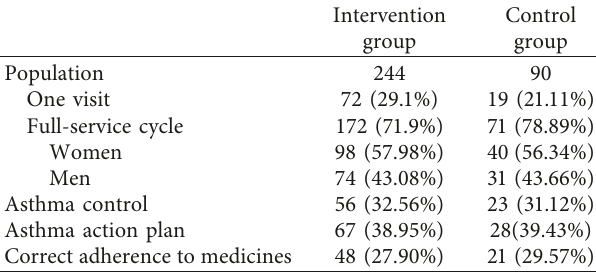
Table 4: Demographics of asthmatic